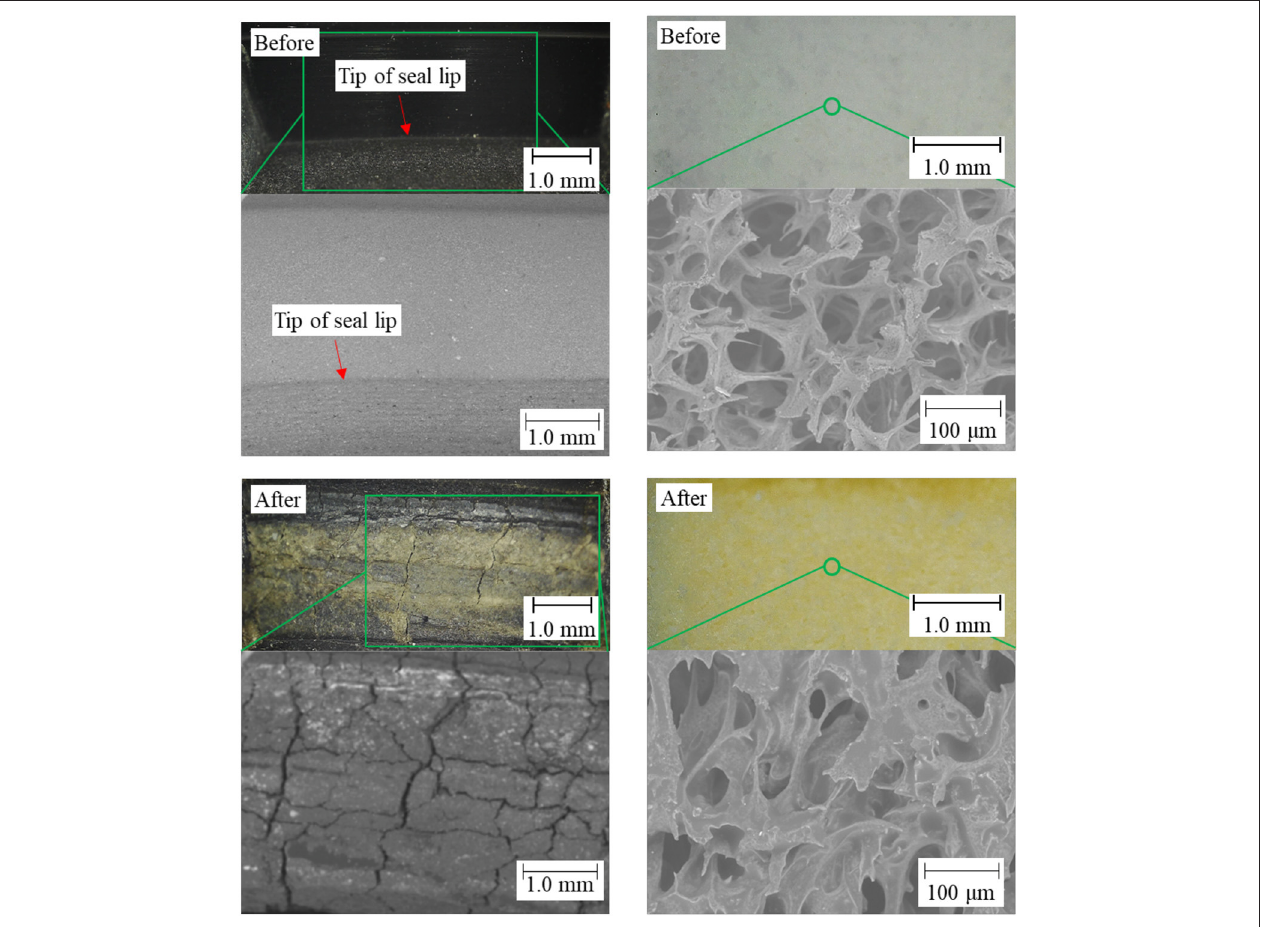
FIGURE 7 | Microscopy and SEM images of the dynamic seal face. Figures to the left are of the oil seal, and figures to the right are of the PVF